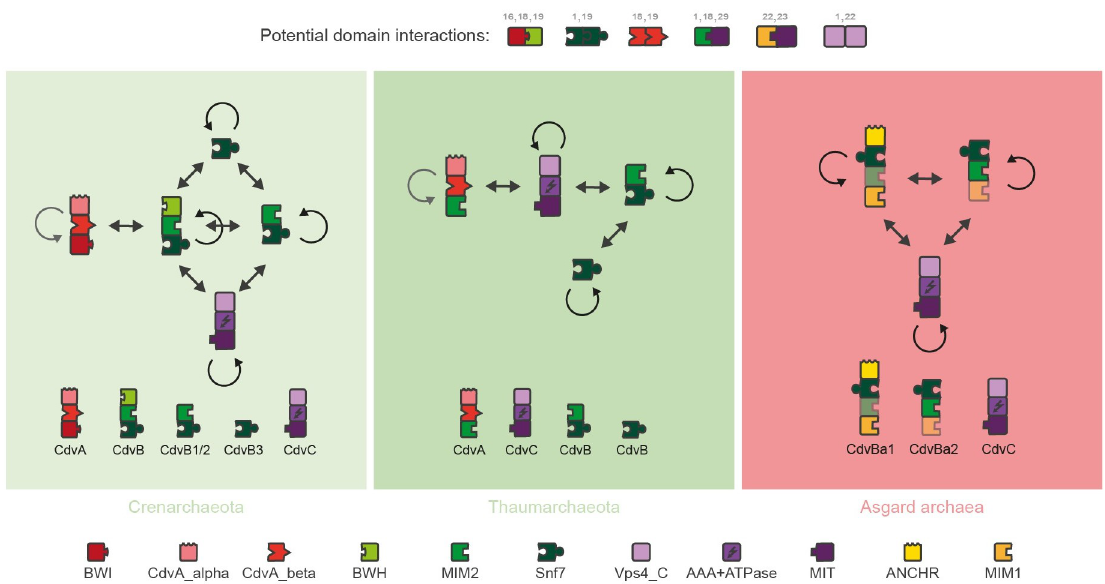
Fig 2. Potential protein-protein interactions of archaeal CdvABC homologs. Proteins are displayed as sets of building blocks, each building block representing one protein domain. Five potential domain-based interactions derived from literature are displayed in the top, grey numbers indicating the literature references where these domain-domain interactions were described. Based on the potential domain- domain interactions, protein-protein interaction networks are shown, where arrows indicate a potential interaction between two domains of the connected proteins. Literature about polymerisation of the CdvA_beta domain varies, so it is displayed in grey instead of black. The networks visualise the interactions of proteins that most likely existed in the last common ancestors of each of the three phylogenetic groups Crenarchaeota, Thaumarchaeota and Asgard archaea (see also Fig 6 ). Thus, this visualises conceptual differences between the three phylogenetic groups, and does not reflect the specific protein interactions of all organisms found today. Abbreviations and colours as in Fig